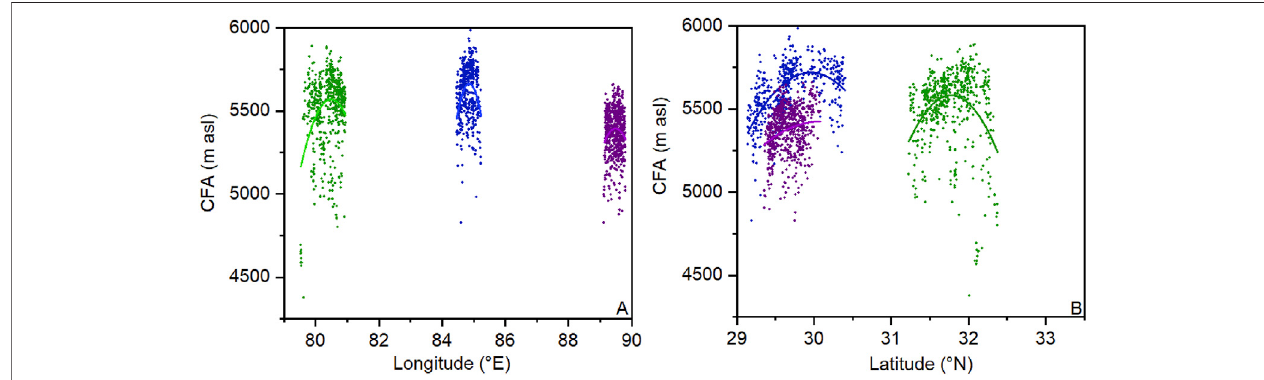
FIGURE 4 | Scatter plots of longitude (A) and latitude (B) and CFA. Green, blue and purple represent the western, central and eastern parts of the Gangdise Mountains, respectively.